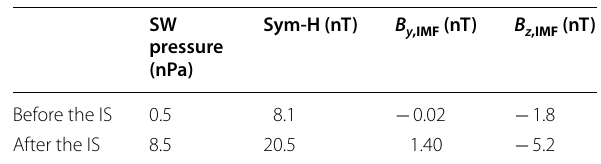
Table 2 Solar wind parameters input to the TS05 model to obtain Fig.